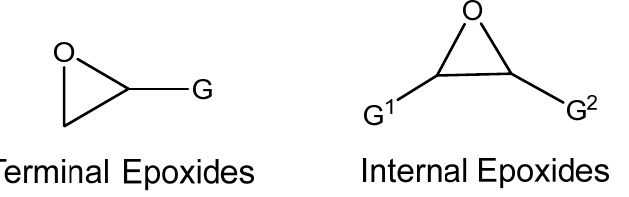
Figure 1. Epoxides available for cycloaddition reactions.